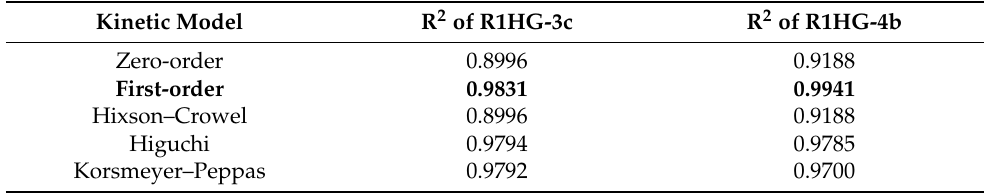
Table 5. Values of the coefficients of determination obtained for all the kinetic models